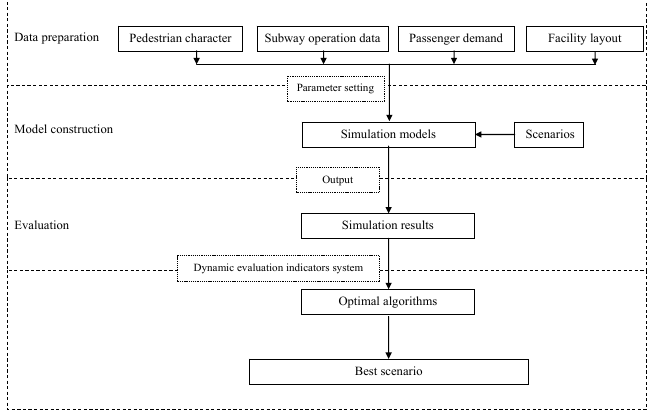
Fig. 1. Framework of evaluation procedure for crowd management in transfer stations based on pedestrian